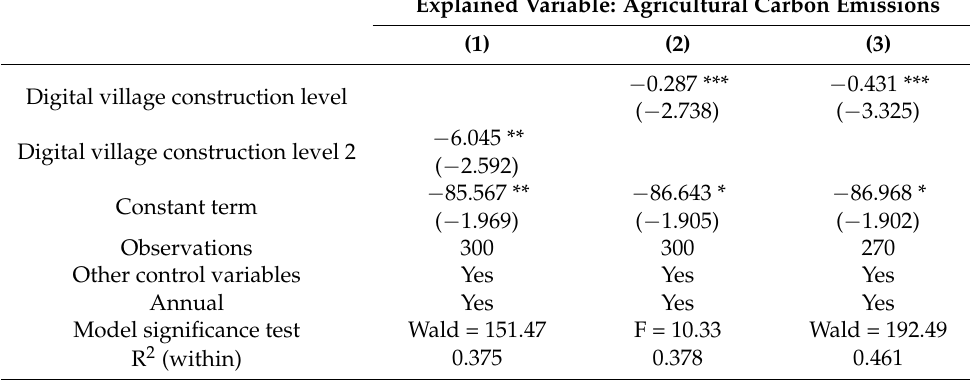
Table 8. Robustness test